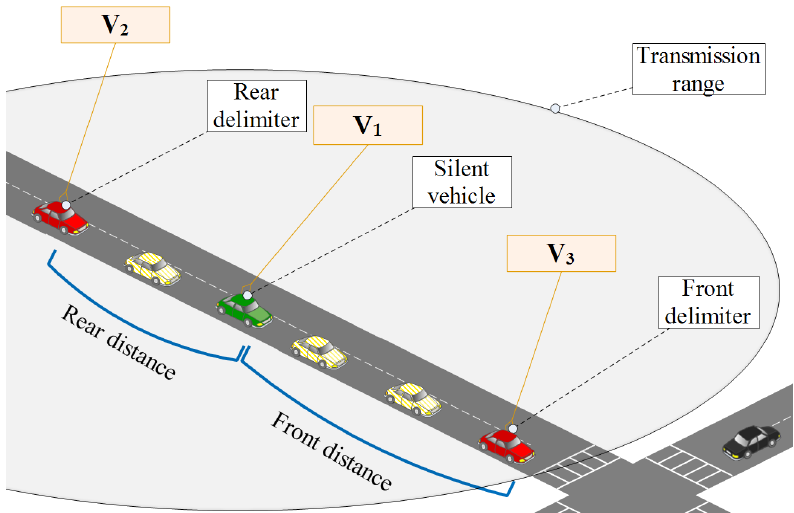
Figure 4. Proposed safety mechanism through front and rear